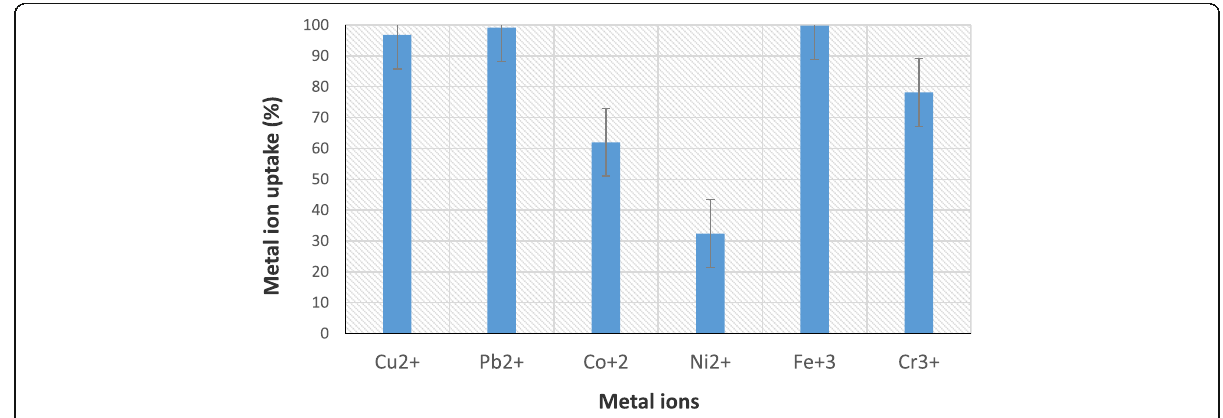
Fig. 6 Effect of mixed heavy metal ions on Cu 2+ uptake (Cu 2+ conc. 80 ppm; Pb 2+ ,Cr 3+ , Ni 2+ , Fe +3 , or Co +2 ,25